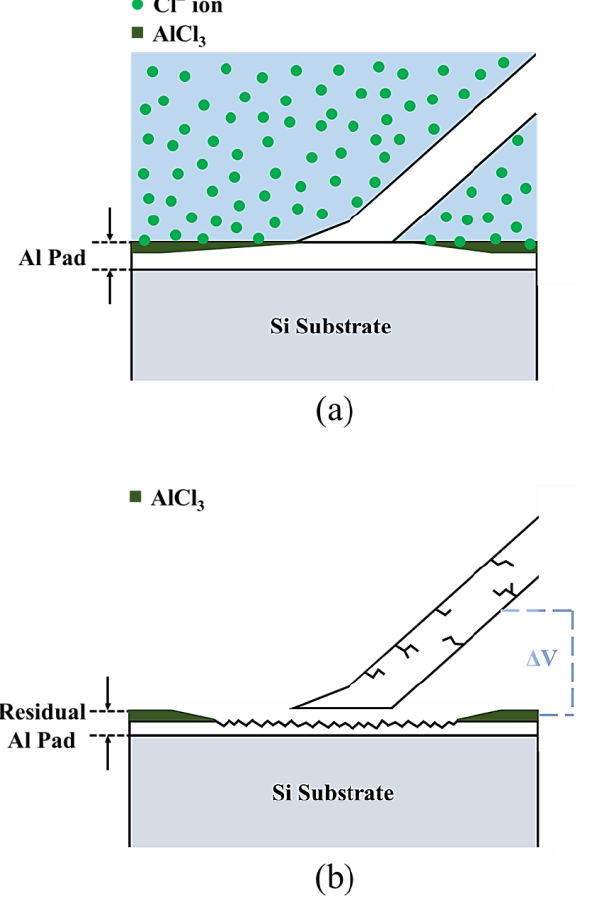
Figure 13. Schematic of the joint of the second bond after chlorination: ( a ) chloride ions corrode the aluminum film; ( b ) partial cracks produced at the joint of the second bond.